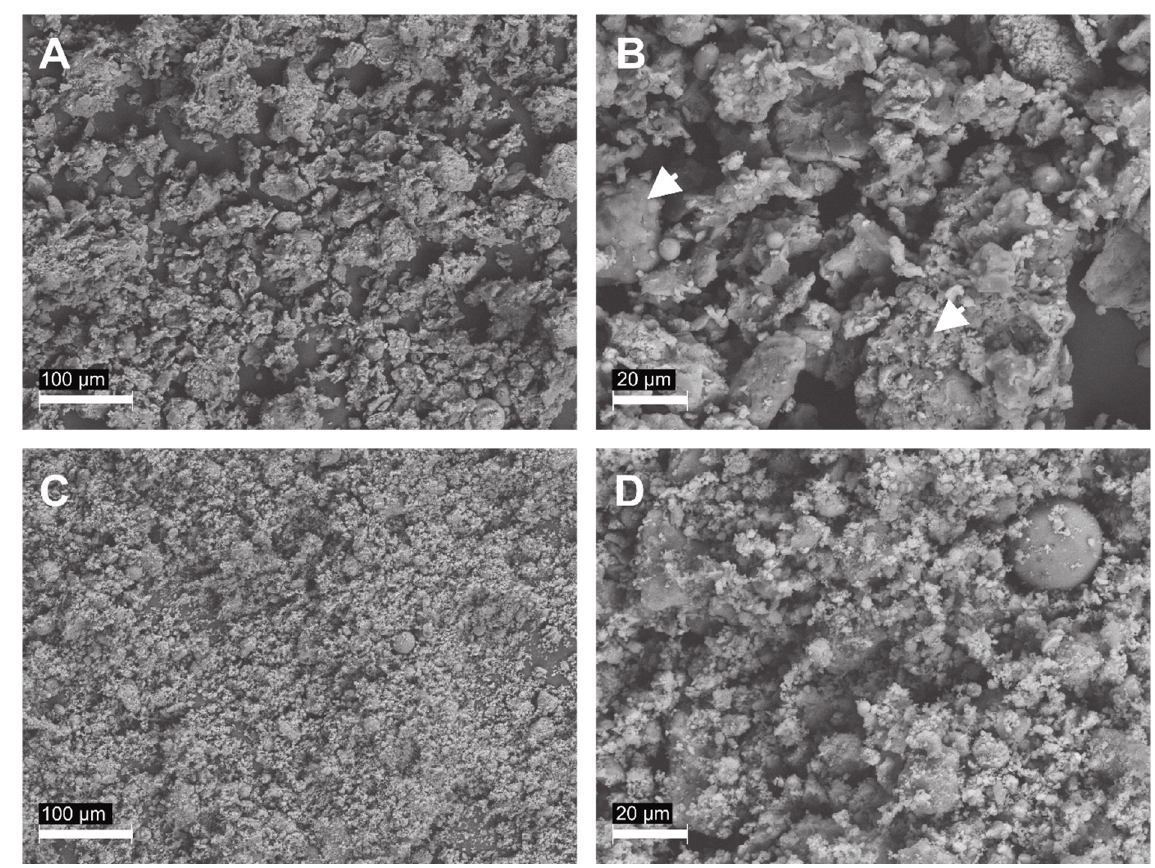
Figure 3. SEM backscattered electron images of the raw ash ( A , B ) and 8 min milled ash ( C , D ). White triangles indicate dense Ca-sulfate crusts on some particles.